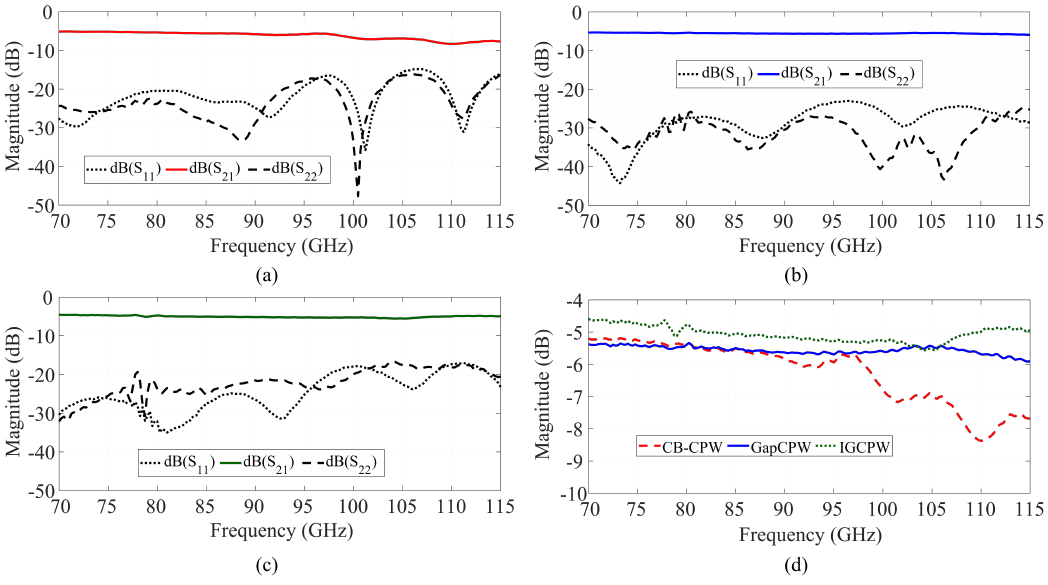
Figure 17. Comparison of the S-parameters of a sample 5-mm-long coplanar line. ( a ) CB-CPW. ( b ) GapCPW. ( c ) IGCPW. ( d ) Comparison of the S 21